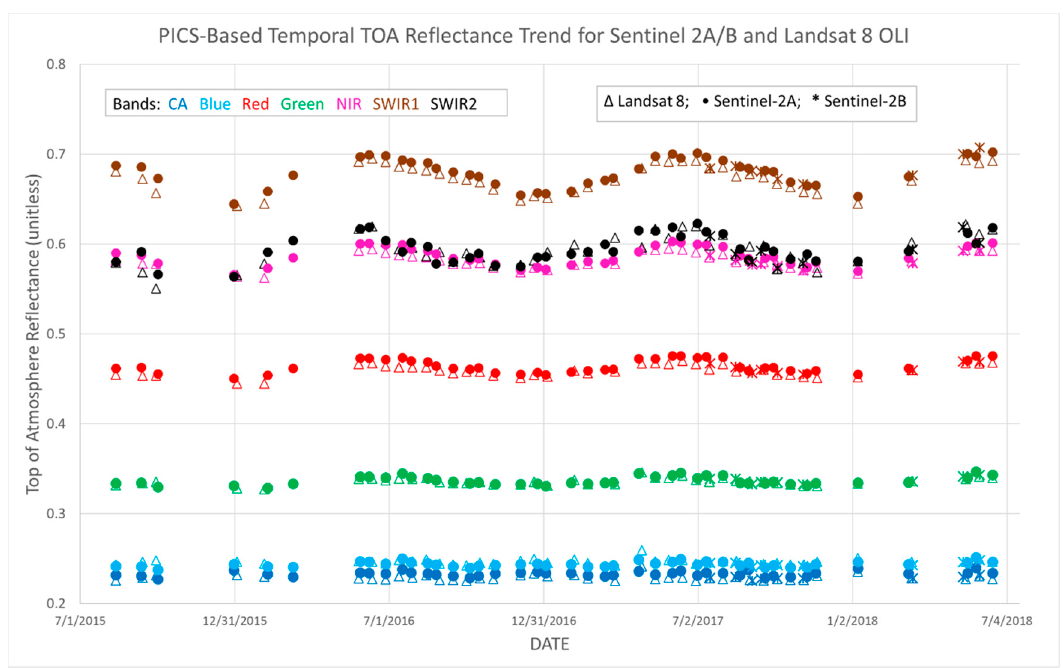
Figure 6. Temporal trends of observations of the Libya 4 PICS by Landsat 8 OLI, Sentinel 2A and Sentinel 2B. These trends allow for cross-calibration of sensors, after accounting for spectral and viewing/illumination geometry differences (however, these data do not include corrections for annual solar elevation angle changes). Observations up to 6 days apart provide the same level of precision as simultaneous observations due to the stability of these sites. Figure courtesy of South Dakota State University Image Processing Laboratory.